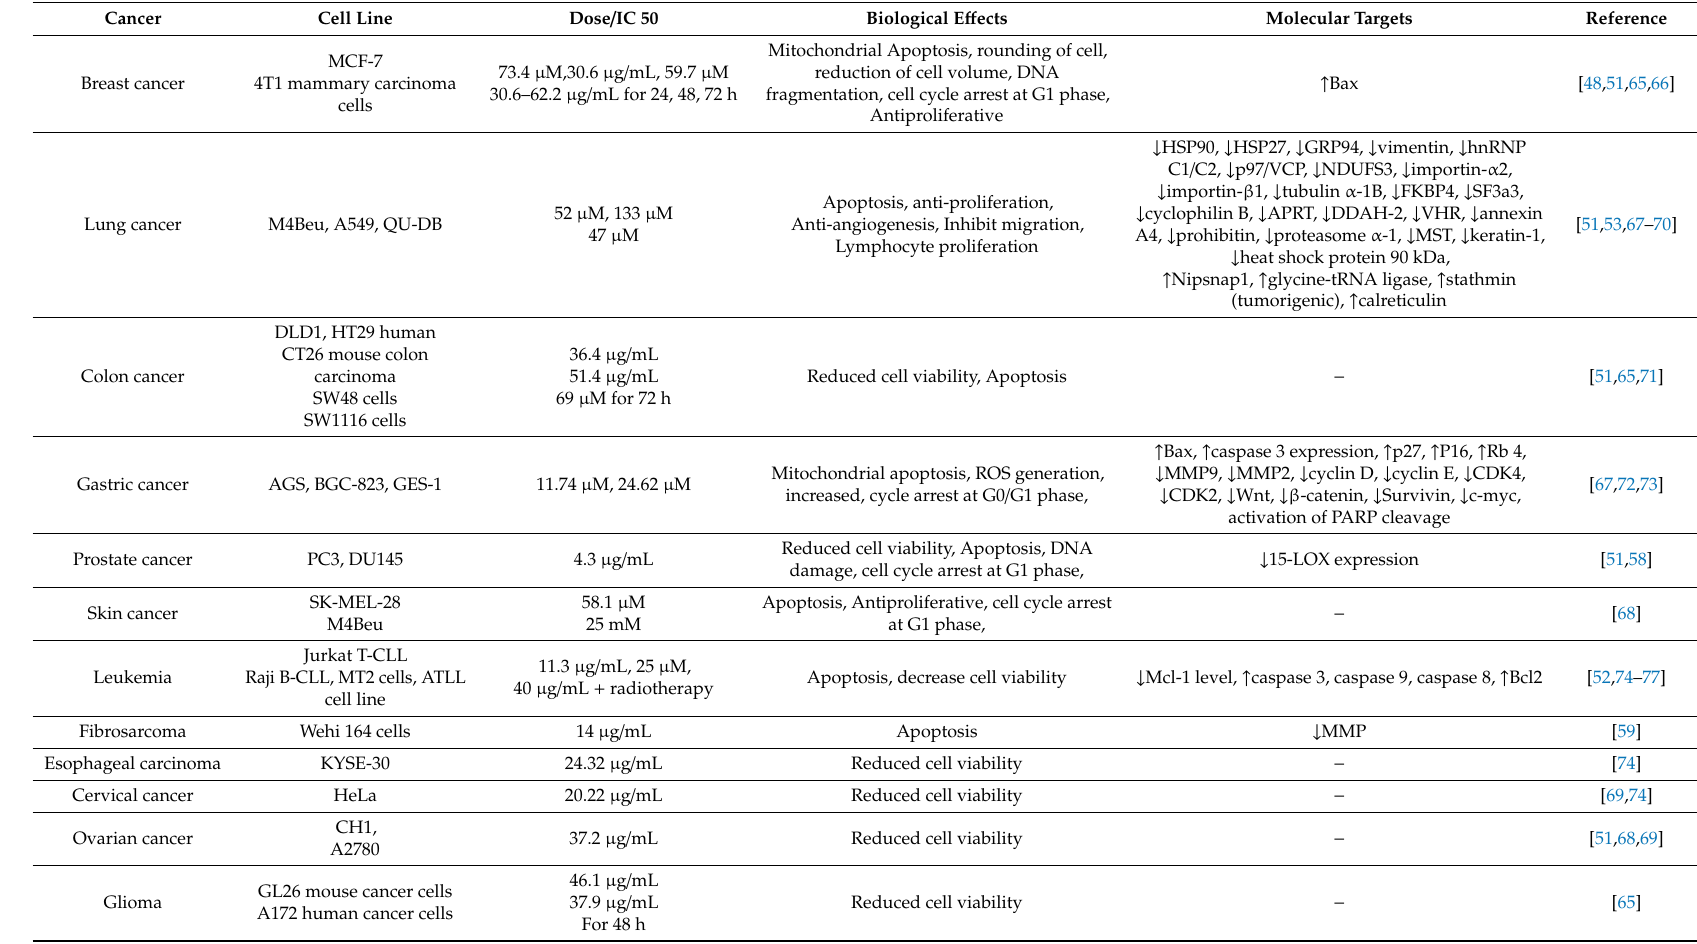
Table 1. In vitro anticancer actions of